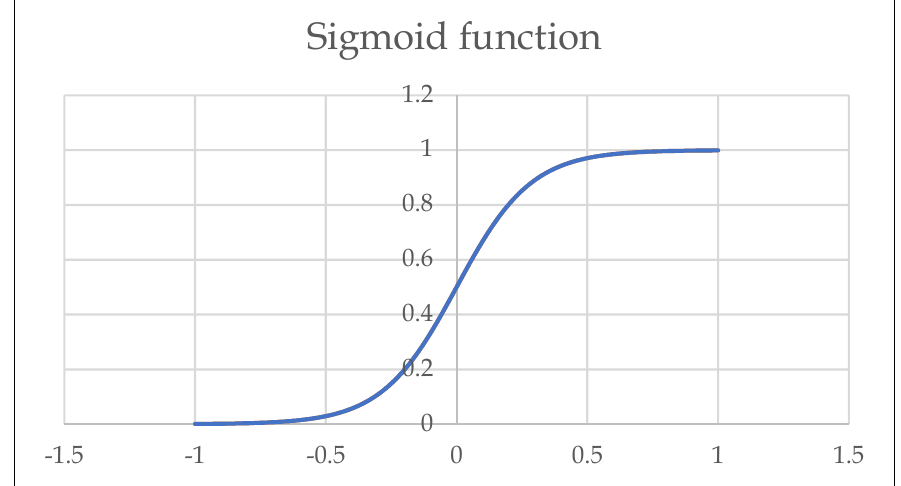
Figure 6. Sigmoid function for 𝑎 = 1 and 𝑏 = 0.